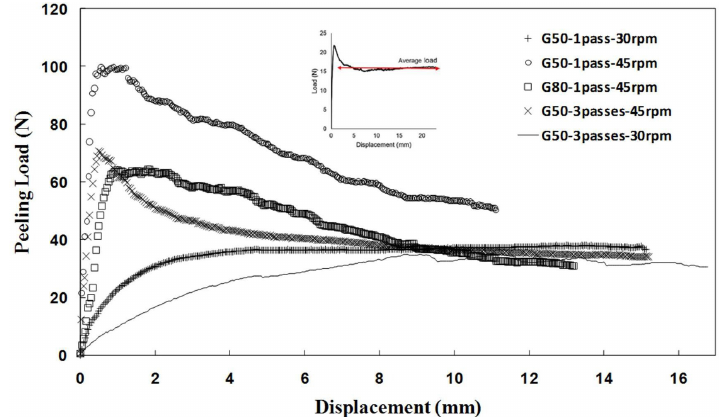
Figure 6. Load versus displacement of Al/Cu/Al sandwich composites at 200°C preheat temperature and 60% thickness reduction.